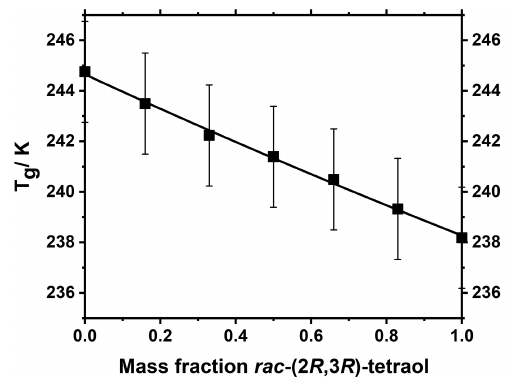
Figure 1. Glass transition temperatures of mixtures of rac -(2R,3S)- tetraol and rac -(2R,3R)-tetraol. The T g values show a nearly linear relationship with a Gordon–Taylor constant k GT of 0.92.